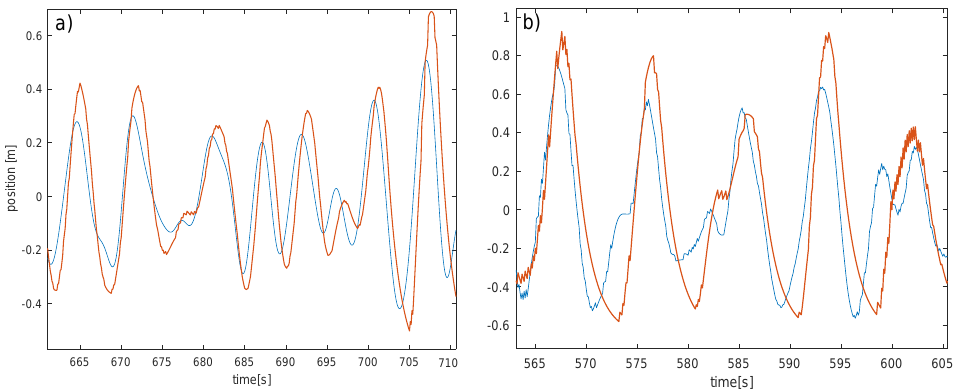
Figure 9. Position of the translator in the numerical simulation for Ts = 7.5 s and Hs = 0.75 m ( a ), and Hs = 1.75 m ( b ). The thin blue curve is from the PTO with low inertia (45 t), the thick orange curve with high inertia (120 t). The damping was set to 75 kNs/m. All values scaled to full scale